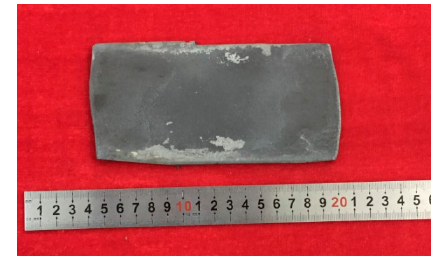
Figure 1. Appearance of the crack-free Ti-43Al-9V-0.2Y alloy sheet.